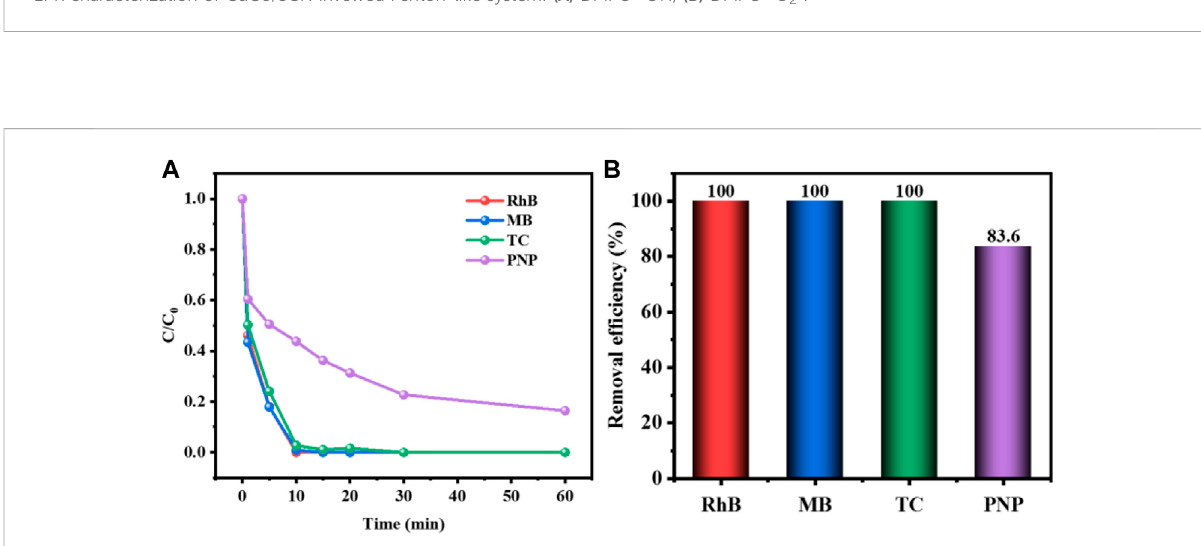
FIGURE 14 (A) Degradation curve and (B) removal ef fi ciency of CuCo/SCN involved Fenton-like system for other organic